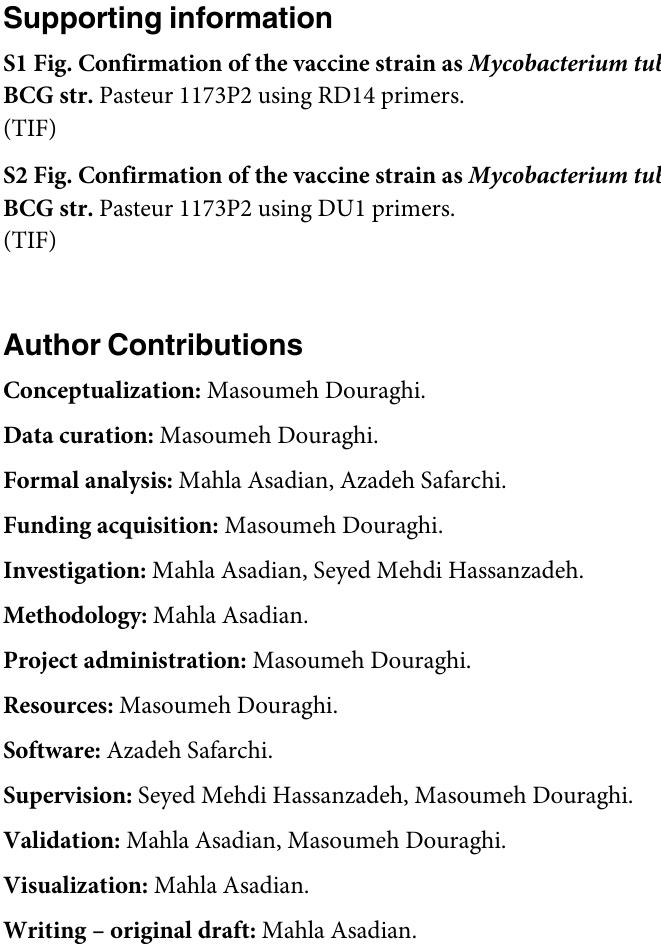
S1 Fig. Confirmation of the vaccine strain as Mycobacterium tuberculosis variant bovis BCG str. Pasteur 1173P2 using RD14 primers. S2 Fig. Confirmation of the vaccine strain as Mycobacterium tuberculosis variant bovis BCG str. Pasteur 1173P2 using DU1